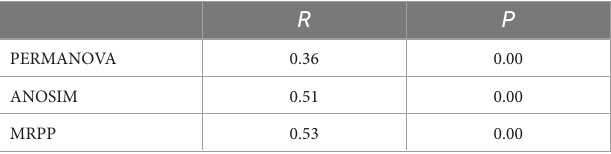
of the variance in phoD-harboring microbial community structure ( Figure 7A ). The Fe (standardized direct effects: − 0.61) and NaOH- Po content (standardized direct effects: − 0.41) negatively and directly affected phoD-harboring microbial community structure, while Bio-P positively and directly affected phoD-harboring microbial community structure (standardized direct effects: 0.60). Standardized total effects derived from the SEM revealed that Bio-P had the